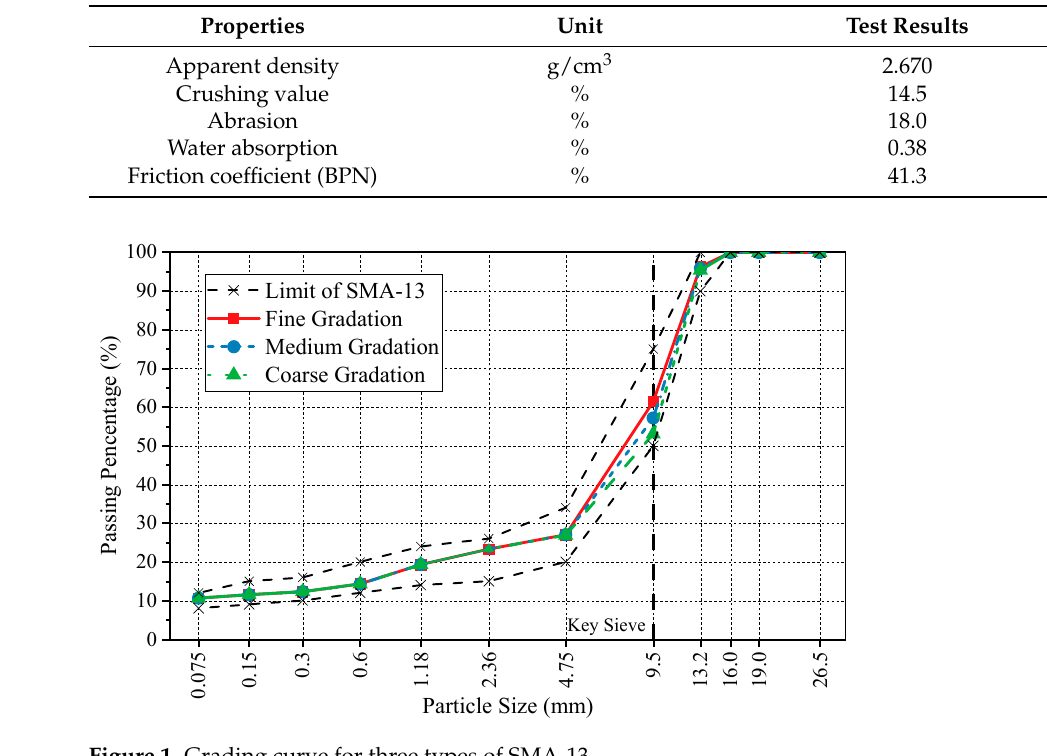
Table 2. Basic properties of aggregates.